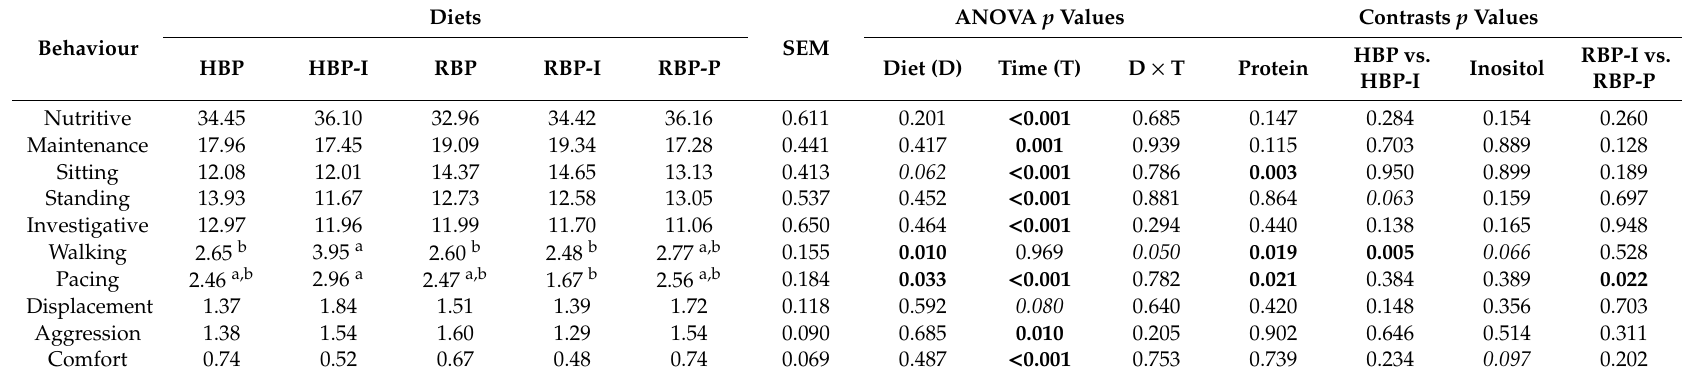
Table 3. E ff ect of protein, phytase and inositol on laying hen behaviour budget (%) from 19 to 59 weeks of